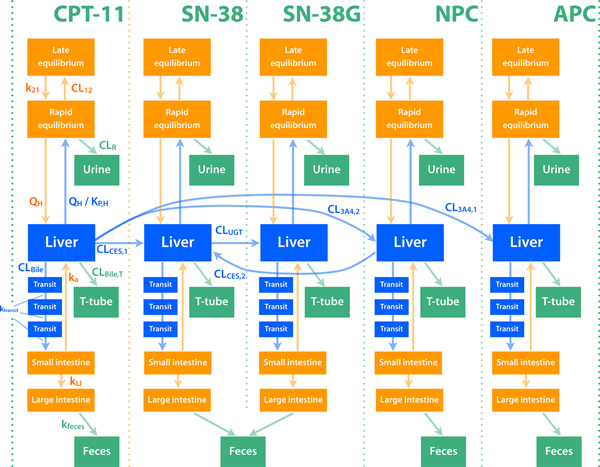
A PBPK model to analyze pharmacokinetic properties of irinotecan and metabolites. We constructed a PBPK model to simulate time profiles of the accumulations of irinotecan and the metabolites. We included compartments for rapid and late equilibrium, liver, small and large intestine, biliary transits, urine, feces, and biliary T-tubes.The ordinary differential equations of this model are described in the Additional file 1. CL12, clearance from a rapid to a late equilibrium compartments; CLCES,1, metabolic clearance of irinotecan by CES2 to form SN-38; CLCES,2, metabolic clearance of NPC by CES2 to form SN-38; CLbile, biliary clearance to a transit compartment; CLbile,T, biliary clearance to biliary T-tube; CL3A4,1, metabolic clearance of irinotecan by CYP3A4 to form APC; CL3A4,2, metabolic clearance of irinotecan by CYP3A4 to form NPC; CLR, renal clearance; CLUGT, metabolic clearance of SN-38 by UGT to form SN-38G; CPT-11, irinotecan; k21, kinetic constant from a late to a rapid equilibrium compartment; ka, absorption rate constant; kfeces, kinetic constant for the transit from large intestine to feces; kLI, kinetic constants for the transit from small intestine to large intestine; KP,H, concentration ratio between liver and rapid equilibrium compartment; ktransit, kinetic constant for the transit in bile compartments to small intestine; QH, blood flow rate in liver.